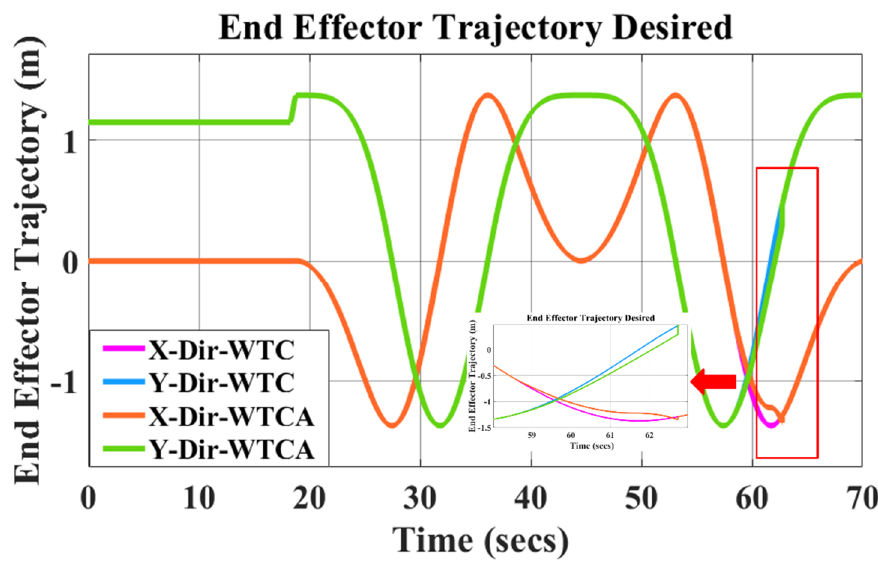
Figure 22. Continuous obstacle avoidance trajectory versus time. WTC = without collision avoidance. WTCA = with collision avoidance.